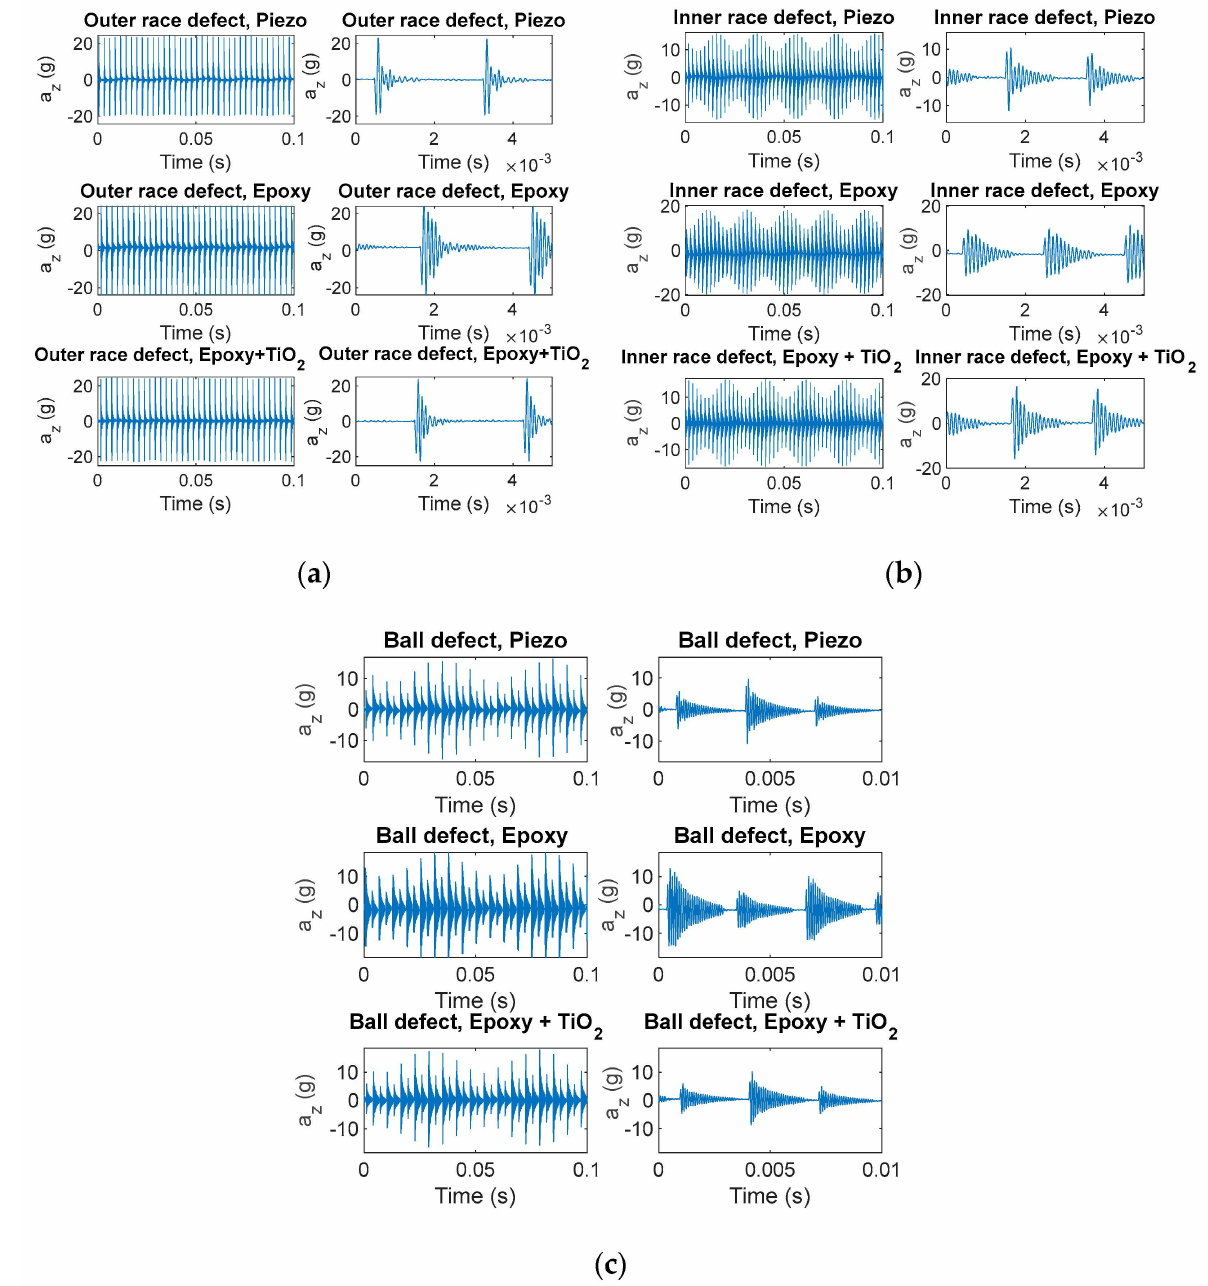
Figure 15. Measured fault signature vibration signals in the time domain. Sampling frequency = 160 kHz. ( a ) Outer race fault; ( b ) inner race fault; and ( c ) ball fault. Upper plots—signals measured by the reference piezoelectric accelerometer; middle plots—signals measured by the pro- posed MDUT encapsulated in epoxy resin; and lower plots—signals measured by the proposed MDUT encapsulated in epoxy resin filled with TiO 2